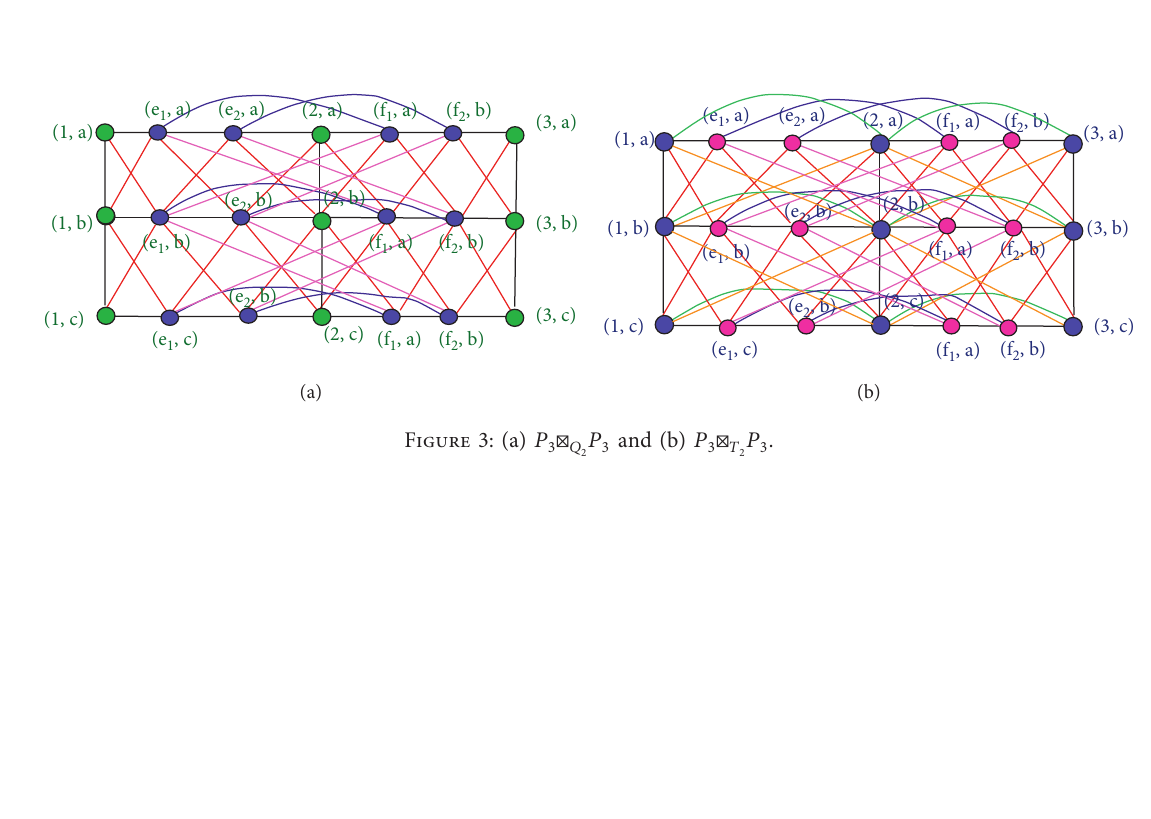
P ⊠ S and (b) P 3 3 2